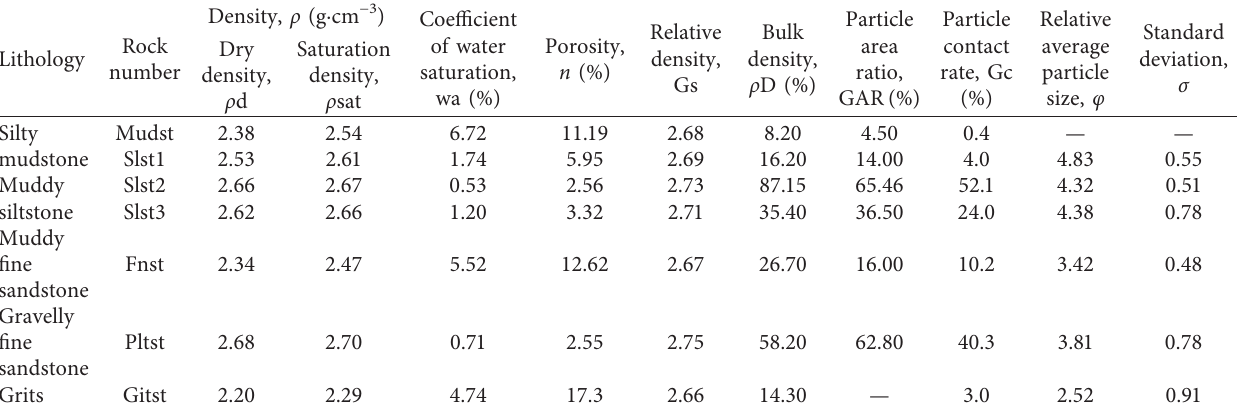
Table 3: Basic physical indexes and microstructure parameters of sandstone.